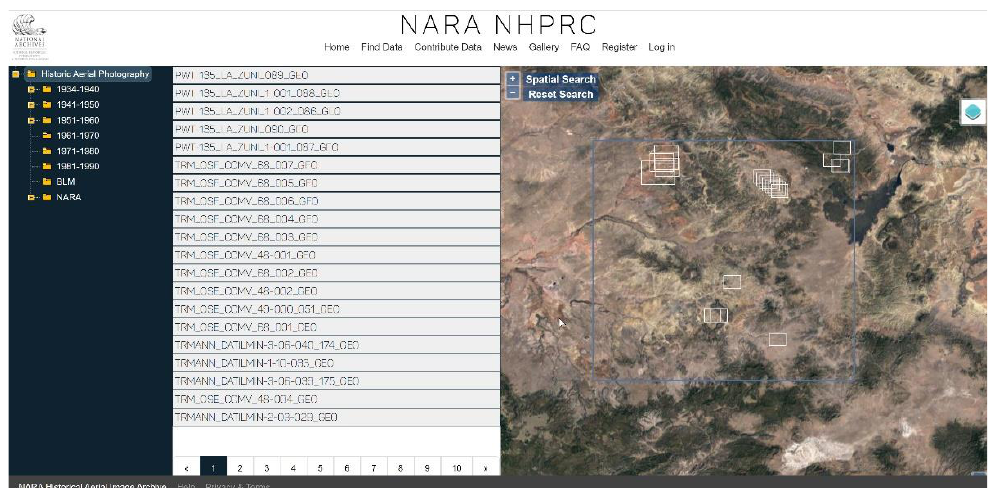
Figure 4. The user interface of the bounding box display tool. The middle panel lists all web-pub- lished historical aerial photos. When a photo is selected (highlighted with a dark blue bar) in middle listing panel, its matching bounding box will be highlighted with a dark blue rectangular box in the mapping panel on the right side, indicating the selected photo’s ground location and coverage.